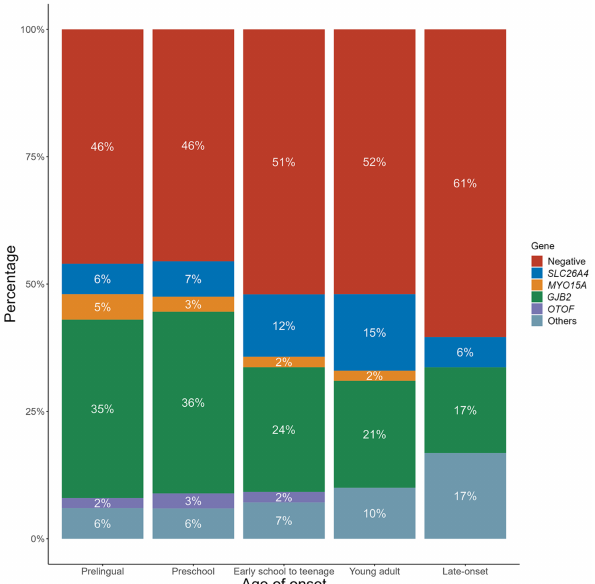
Figure 2. Genetic etiologies by age of onset. The rates of negative results increased by age, with GJB2 variants being more likely detected in patients with onset at prelingual age. By contrast, the percentage of SLC26A4 variants were relatively higher in patients with onset from early school to young adult than the other age